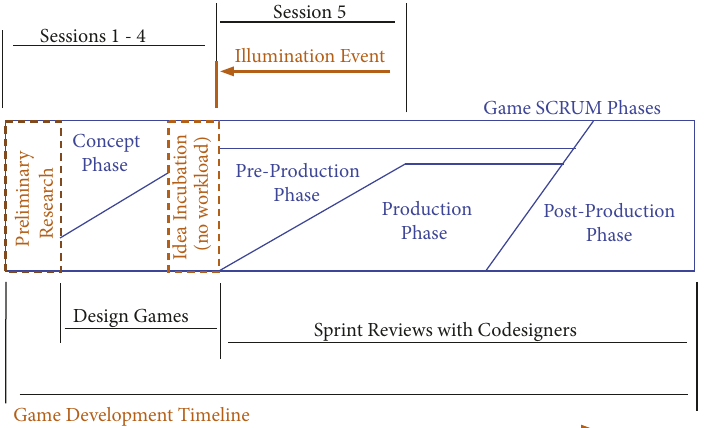
Figure 24: Flow of the process stages during game development: the framework stages overlap with Game SCRUM phases and Creative Process’